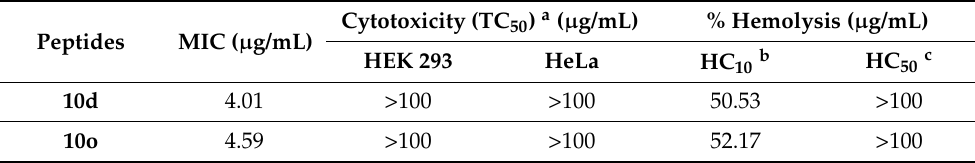
Table 4. Cytotoxicity and hemolytic activities of the active peptides. Peptides